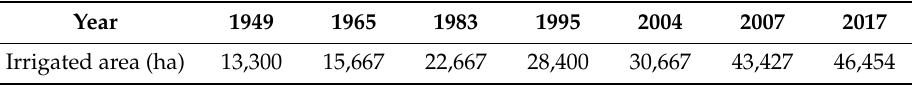
Table 1. Development of irrigated area in Changma Irrigation District.